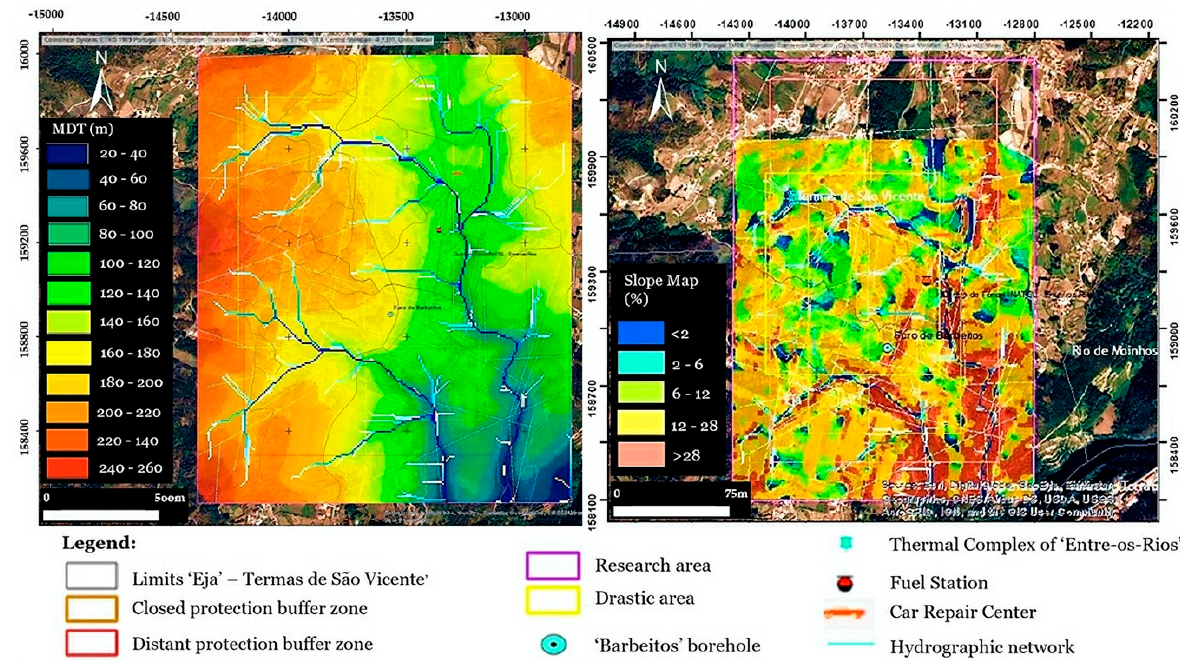
Figure 3. Model digital terrain and slope map of the area surrounding the ‘Barbeitos’ borehole.